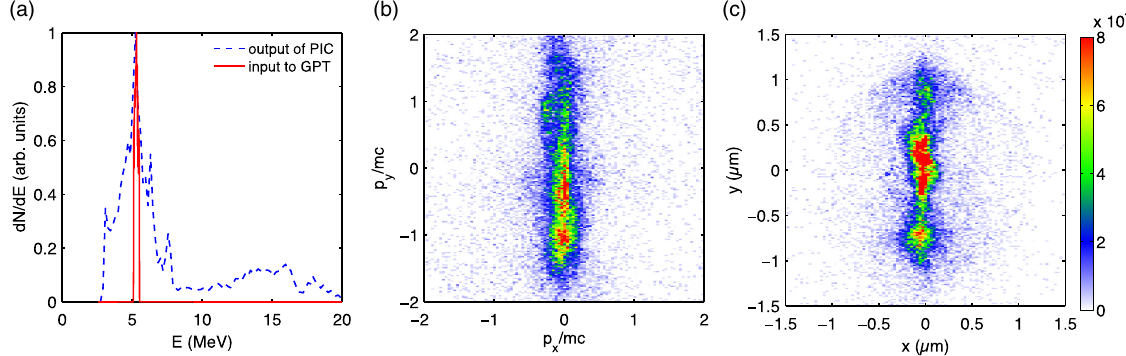
FIG. 2. Results from PIC simulations. (a) Blue line: Electron energy distribution at the output of the PIC code. Red line: The filtered energy distribution ( δ E=E ¼ 2% ) which is used as an input of the particle transport code (GPT). (b) Electron distribution in transverse phase space ð p x ; p y Þ and (c) in real laboratory space ð x; y Þ . Both plots show an elongation of the distribution along the direction of laser polarization.